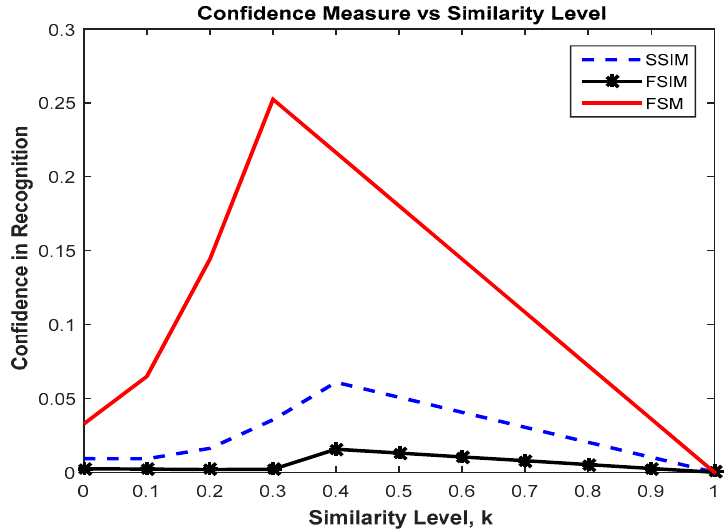
Figure 12. Recognition confidence for similarity measures SSIM, FSIM and FSM using person No. 4 (pose 10) in the AT&T database.